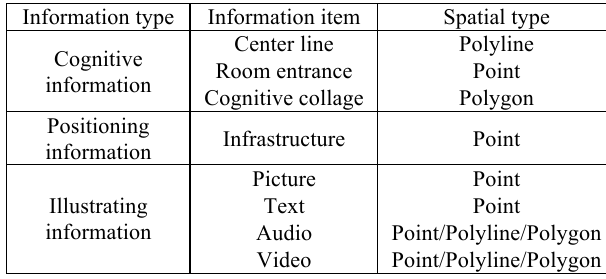
Table 1. Geocode different kinds of spatial information